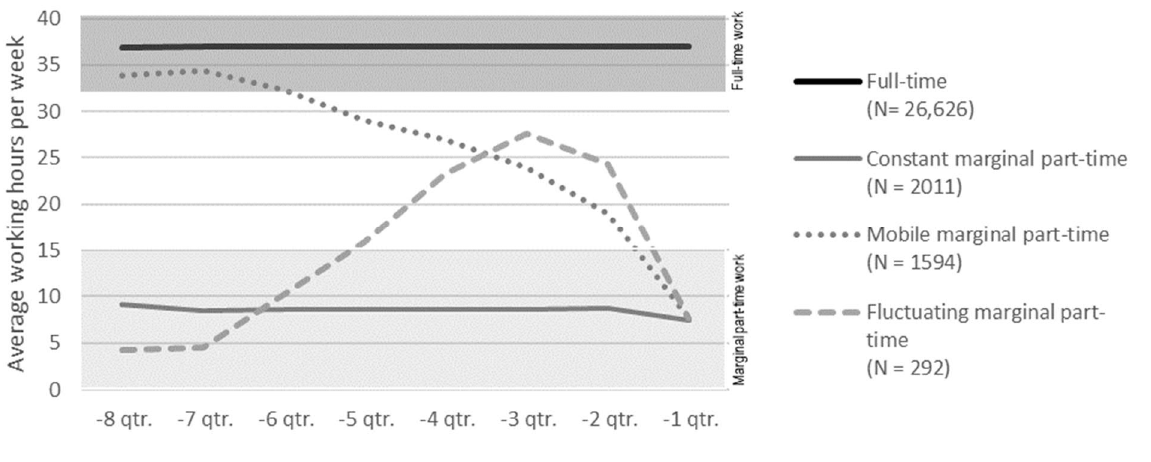
Figure 3. The average number of weekly working hours in the two years leading up to baseline by each retrospective trajectory